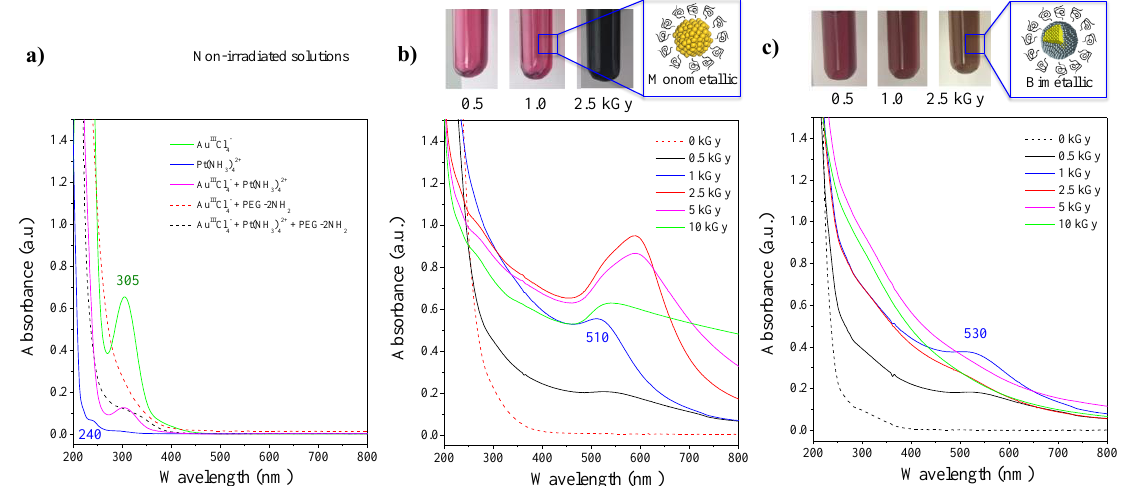
− (5 × 10 − 4 mol.L − 1 ) 4 − 4 − 4